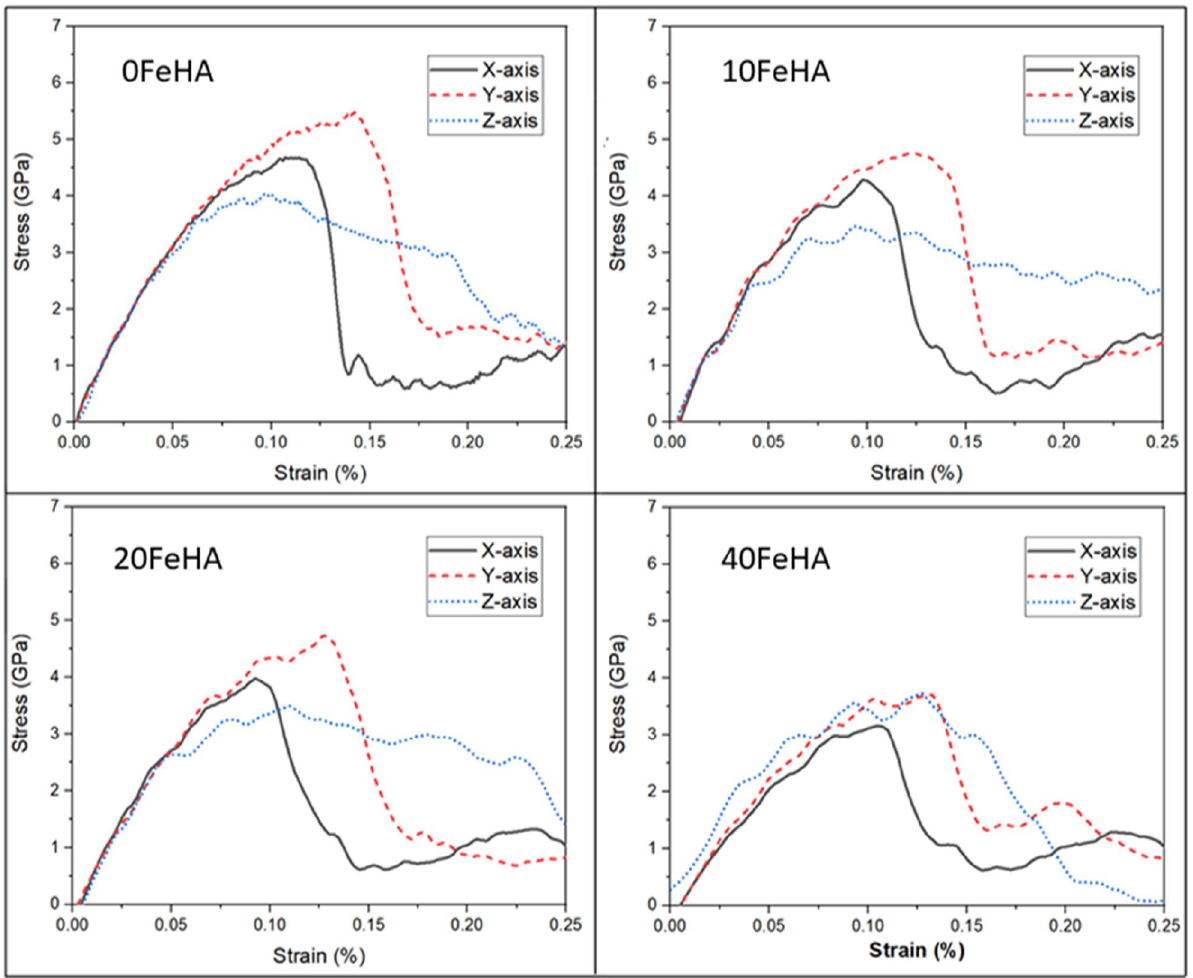
Figure 6. Uniaxial tensile stress–strain response at T = 300 K for different doped HA, as analyzed using MD simulation. (Sample designation: xFeHA means x mol% Fe 2+ -doped HA). The tensile loading directions along different crystallographic orientations follows similar manner as shown in Fig.